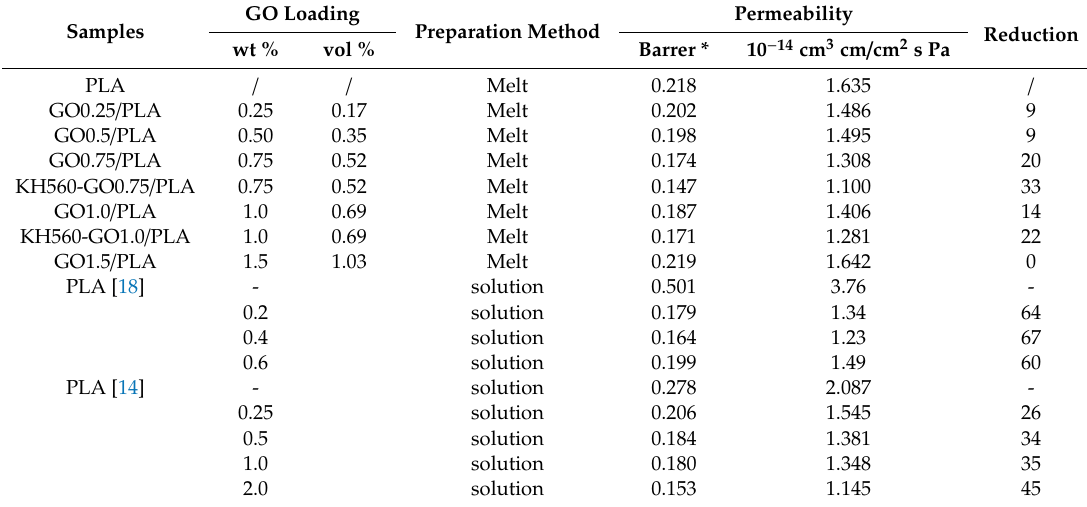
Table 2. Gas permeability of graphene oxide / PLA nanocomposite films.